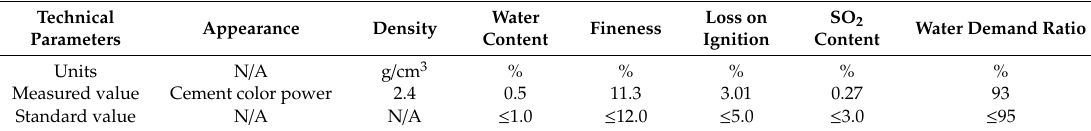
Table A4. Technical parameters of fly ash.